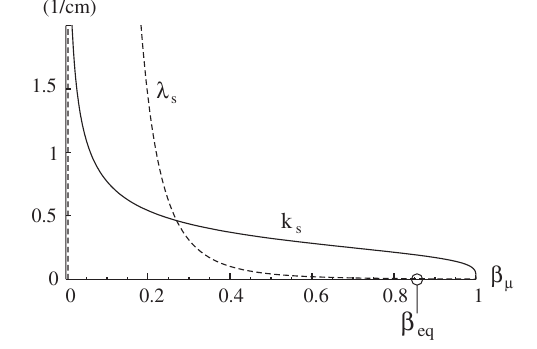
FIG. 11. Dependence of (cid:4) s and k s on the value of relativistic beta of muons, (cid:2) (cid:1) , in Li-rod with a field on its surface of 200 kG and the diameter of 2